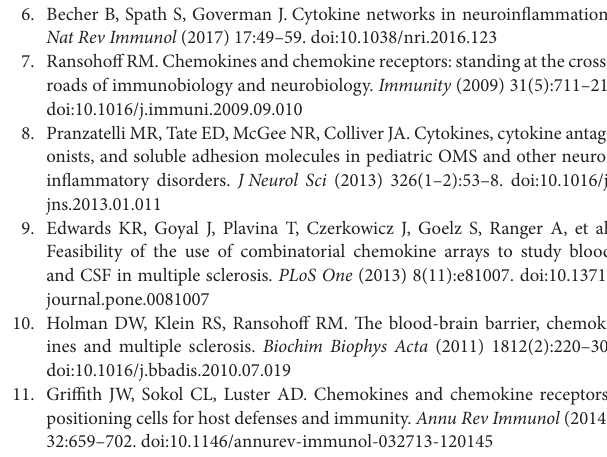
FiGURe S1 | Cytokine concentrations in (A) cerebrospinal fluid (CSF) and (B) serum. Means with standard deviation (SD) in parentheses ( larger figure ) and medians with interquartile range in parentheses ( insert ) are ranked. Other medians could not be calculated due to the number of samples with undetectable levels. FiGURe S2 | Cytokine detection rates in CSF and serum in the entire dataset. Percent detectability was defined as the percentage of samples in which a given cytokine could be detected. The order of the cytokines displayed is from the highest to the lowest CSF detection